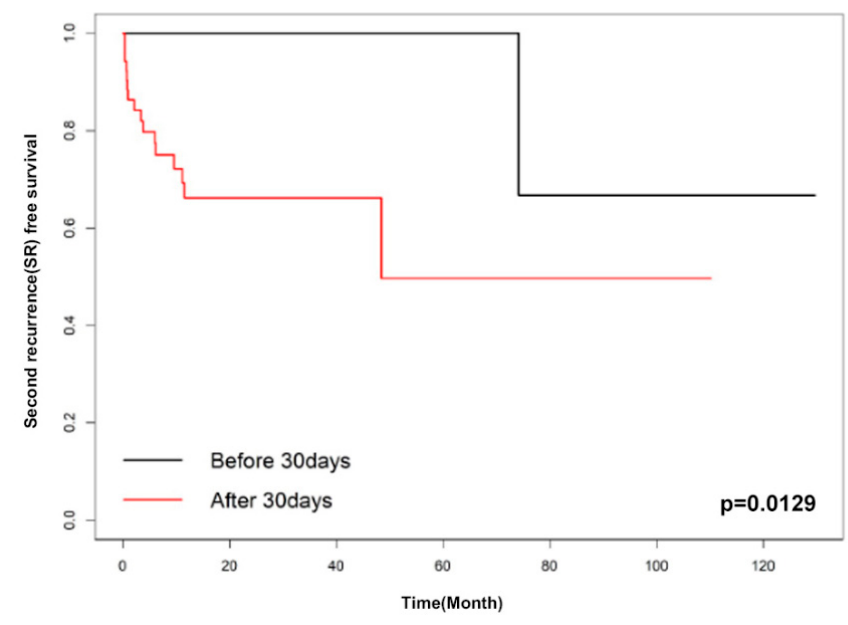
Figure 2. Kaplan–Meier curve of early recurrence and late recurrence (cut-off: 30 days).